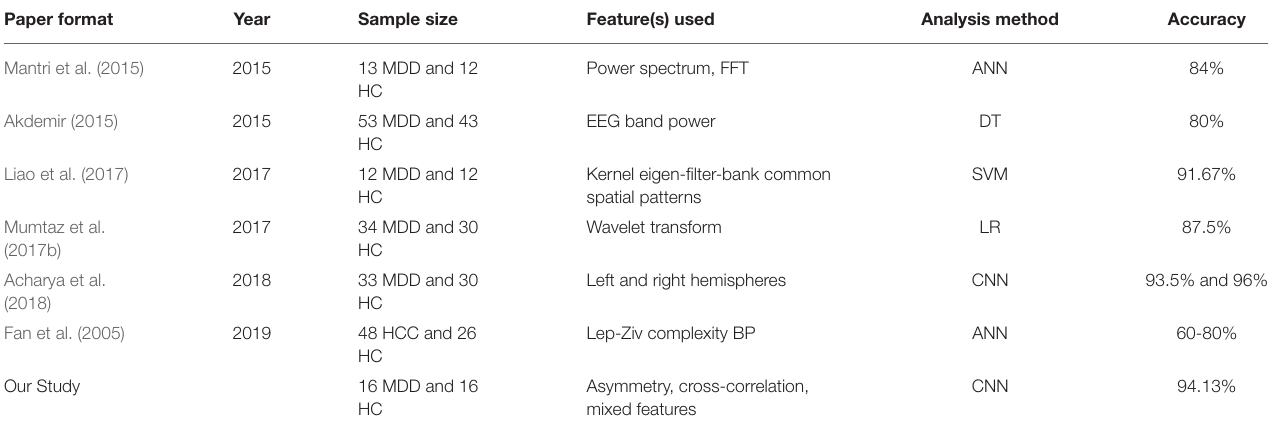
TABLE 4 | Summary of previous works on EEG signal analysis for